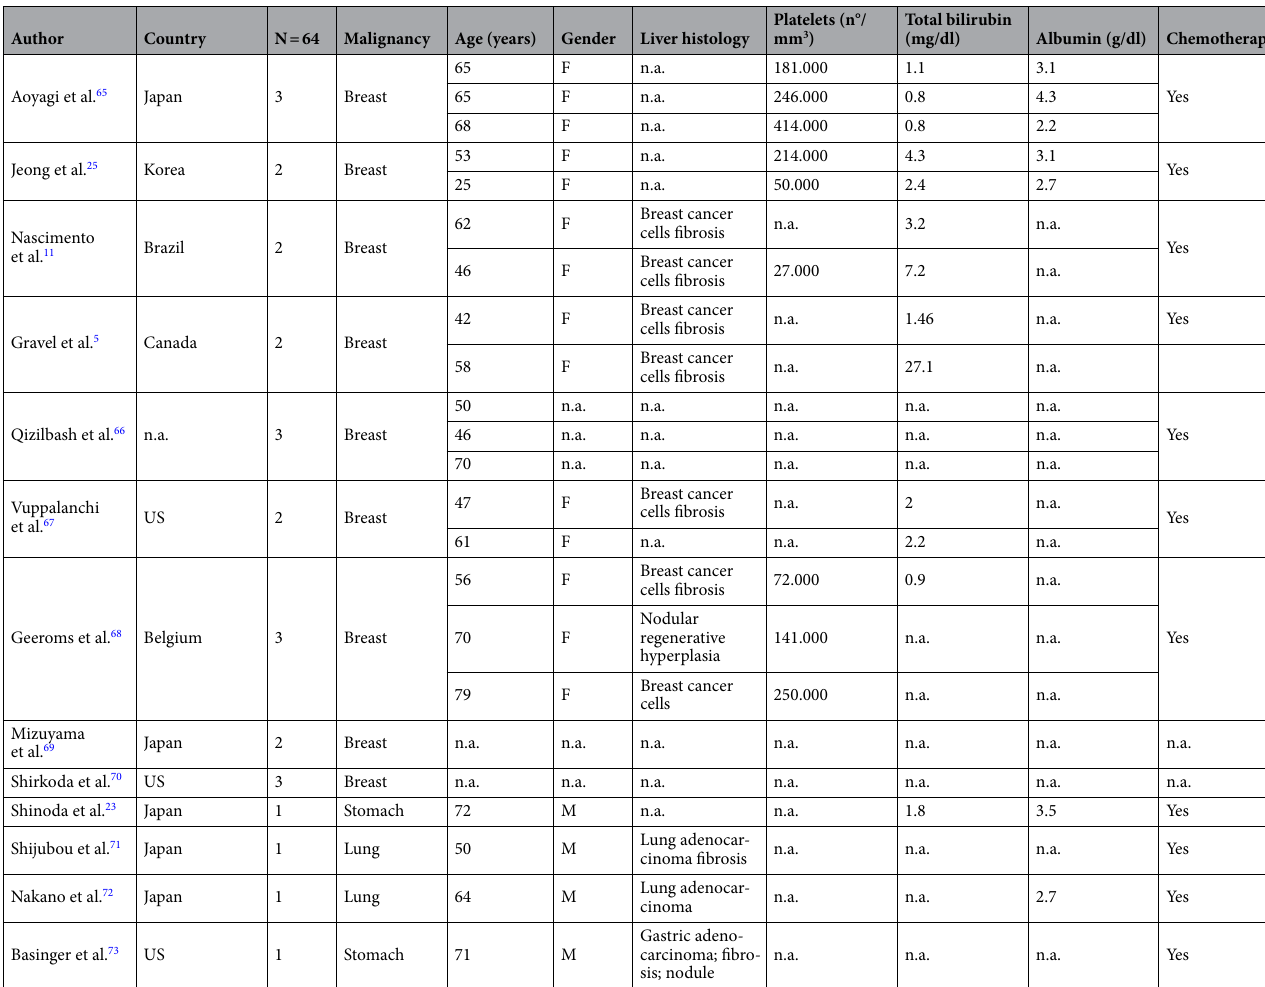
Table 1. Case reports included in the final